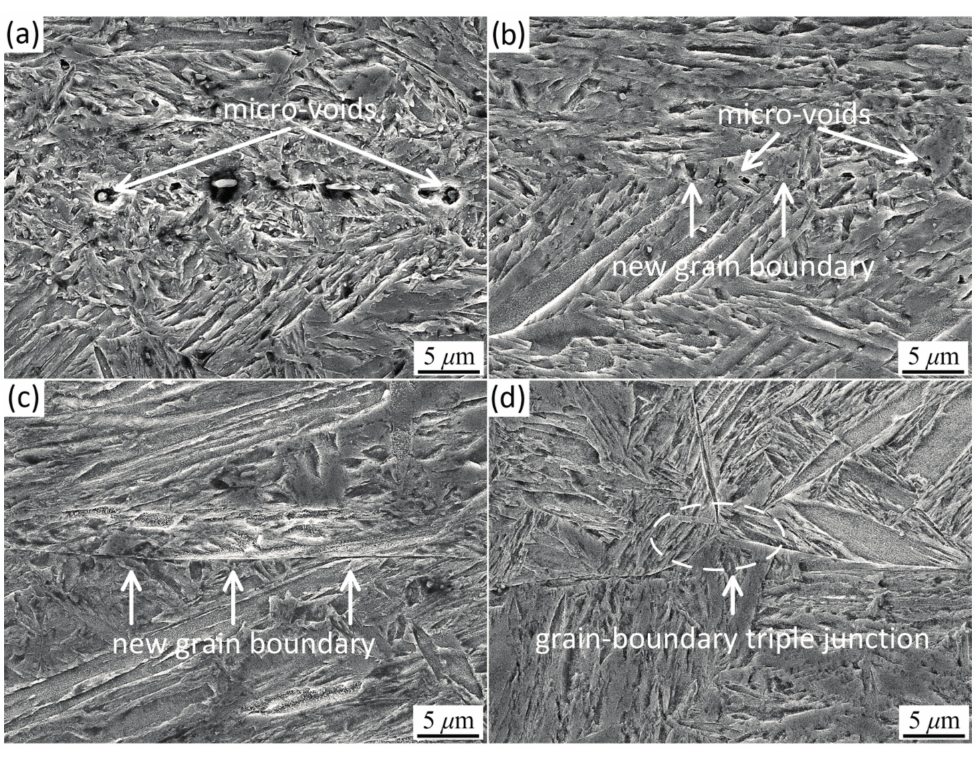
Figure 6. SEM micrographs of the crack healing zone at 1200 ◦ C for different holding times: ( a ) 5 min; ( b ) 15 min; ( c ) 30 min; and ( d ) 60 min.